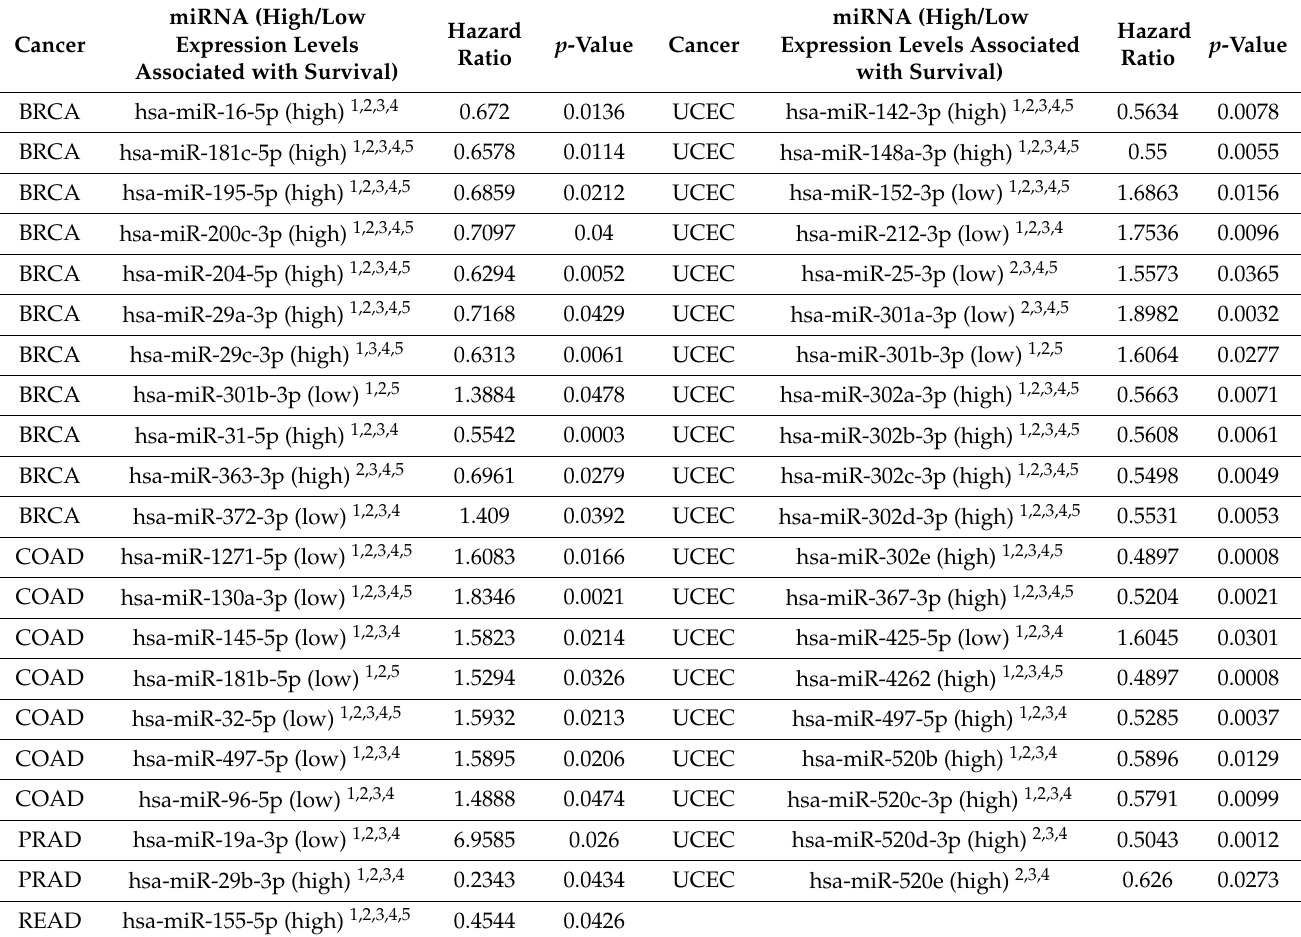
Table 3. Logrank test results (survival analysis) for miRNAs in the shared ceRNA network of hormone-dependent (HD)